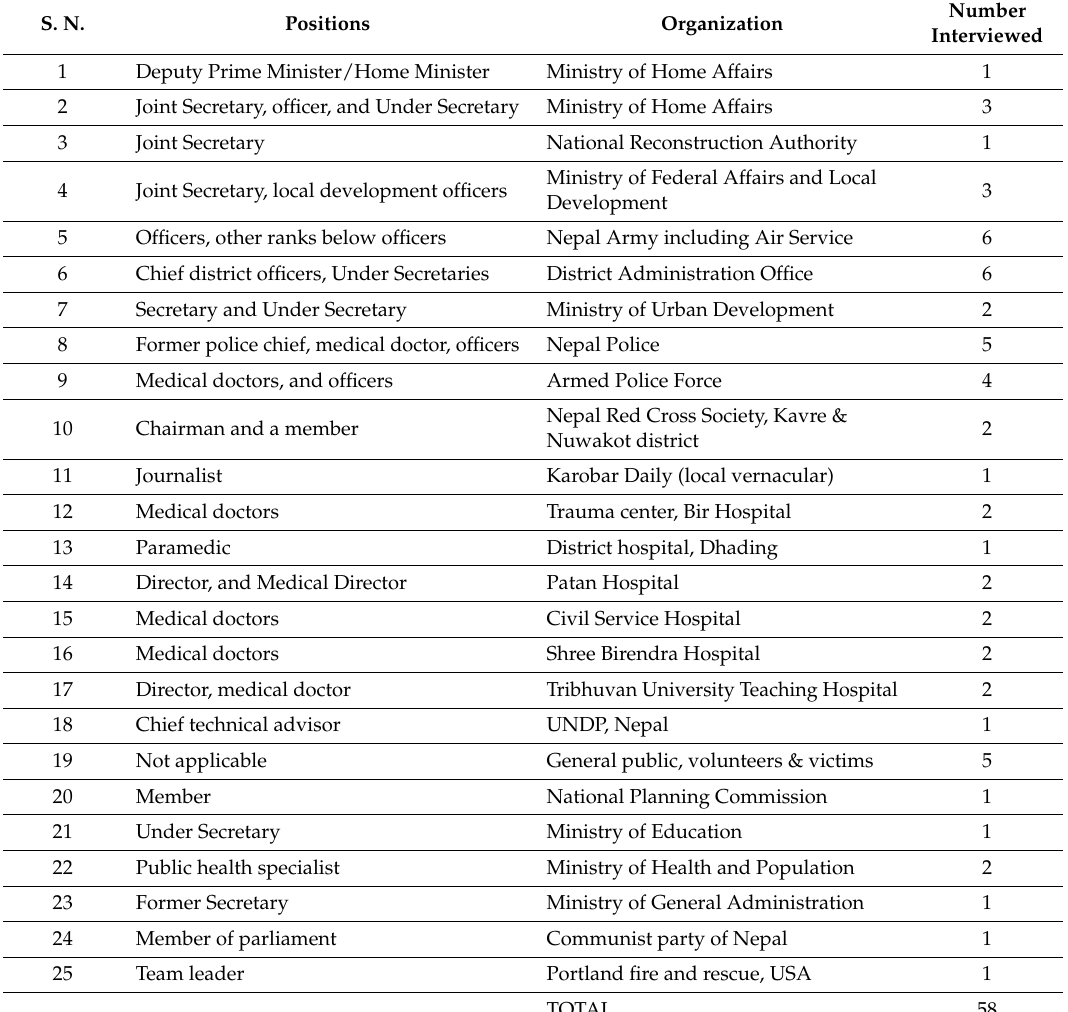
Table 2. Details of 58 interviewed